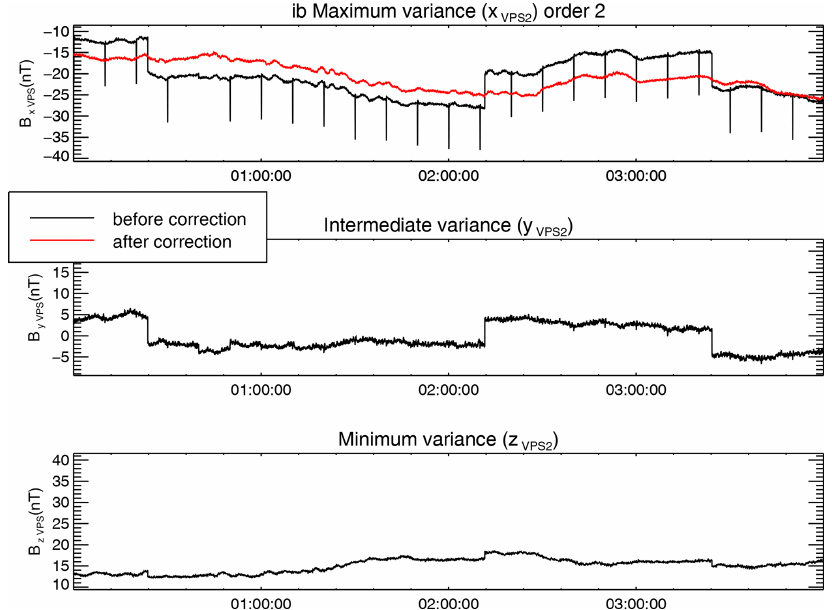
Figure 5. The first- (black) and the second-order correction (red) for the inboard FGM sensor. Mean values were